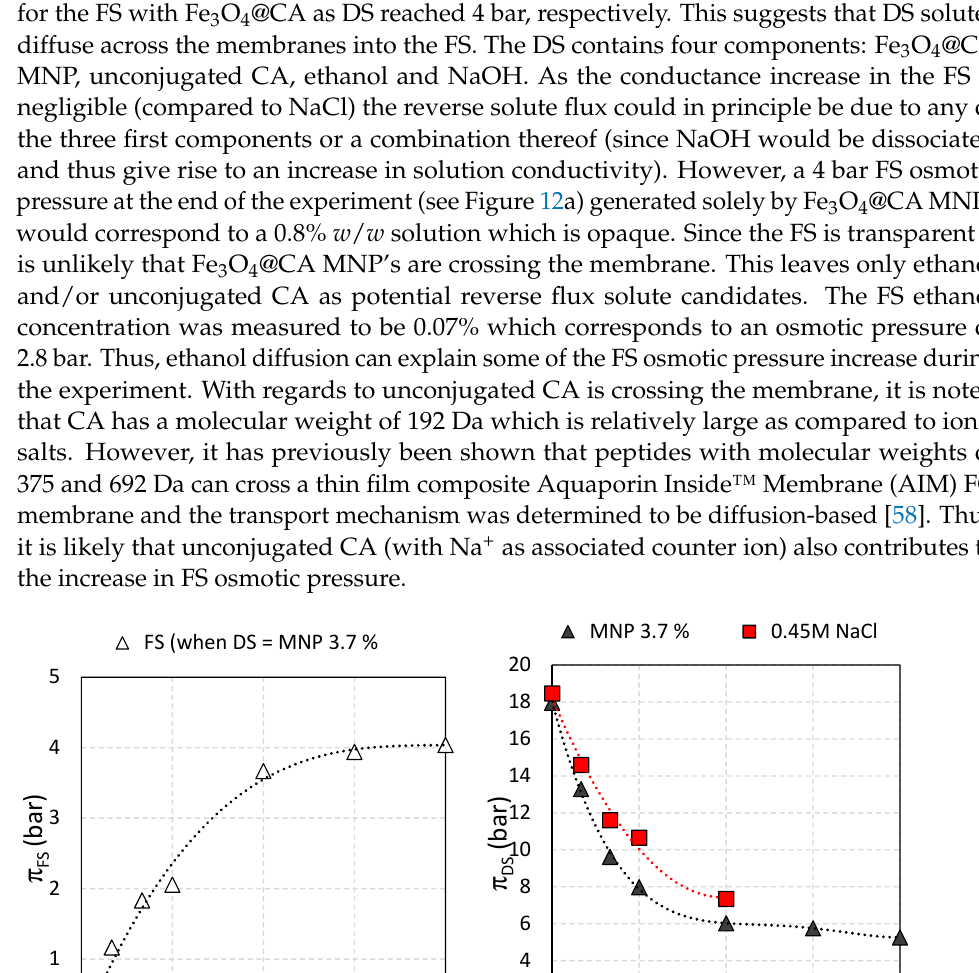
Figure 12. Osmotic pressures when DS is ( a ) Fe 3 O 4 @CA and ( b ) 0.45 M NaCl, during the time. Black columns present the osmotic pressure in the DS during filtration, which is decreasing because of two factors: (i) outcoming salts from DS to FS (yellow part of columns) and (ii) incoming water from the FS that is diluting DS (hatched part of columns). 3.5. Characterization after FO Process The functional groups of chemical bonds between Fe 3 O 4 and CA after the FO process were characterized by FTIR (Figure 13a). It is confirmed that the Fe 3 O 4 @CA spectral fea- tures are preserved, so the CA coating on Fe 3 O 4 MNPs was maintained. The TGA results in Figure 13b show the weight loss of Fe 3 O 4 @CA before (black curve) and after the FO process (red curve). The overall weight loss of Fe 3 O 4 @CA before the FO process was de- termined 8.3% and after the FO process 6.6%. The total estimated number of COOH groups is still 85 molecules per particle after FO process.